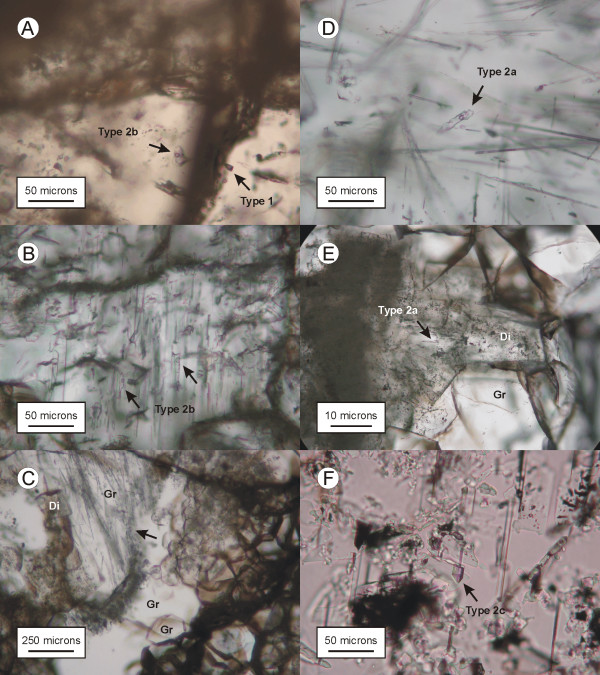
A serie of photomicrographs showing the distribution, shape and interrelationships with host minerals and other inclusions of primary type 2 fluid inclusions. (A): Comparatively large type 1 and type 2b fluid inclusion coexisting in the same zoisite crystal (sample Dior-2). The type 2b inclusion is isolated. Two smaller type 1 inclusions are present near the lower left part of the one indicated by a black arrow, which together form a small group. (B): Rod-shaped fluid inclusions in a diopside crystal (sample Dior-1). The inclusions are randomly distributed and are oriented parallel to the c axis of the crystal. (C): Image showing acicular inclusions in grossular (Gr) from sample Gran-1b. Some of the inclusions consist of diopside needles and others are fluid filled. The occurrence of these inclusions is restricted to certain sectors within larger grossular crystals (black arrow). Type 2a fluid inclusions in grossular most commonly occur in these acicular clusters. Coarse-grained diopside crystals (Di) are abundant in the grossular and contain the same type of fluid inclusions. (D): Detail of an elongated type 2a fluid inclusion in grossular from sample Gran-1b. (E): Image showing diopside filling interstices between euhedral grossular crystals in veins from sample Slate-1a. A type 2a fluid inclusion in the diopside is shown by a black arrow. The grossular also contain type 2a fluid inclusions. Type 2a fluid inclusions in samples Slate-1a and Gran-1b showed the same behaviour during cryogenic experiments. (F): A type 1c fluid inclusion (black arrow) in vesuvianite sample Ves-2. This inclusion is oriented parallel to the c axis of the host crystal. Other needle-shaped inclusions can be seen oriented in the same way. They consist mostly of empty cavities.